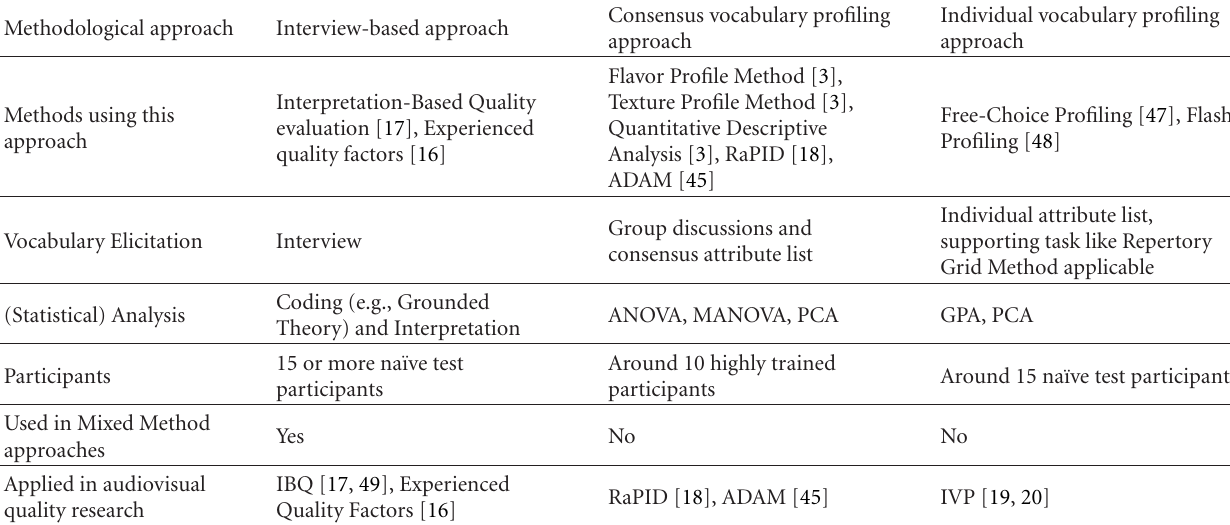
Table 1: Descriptive perceived quality